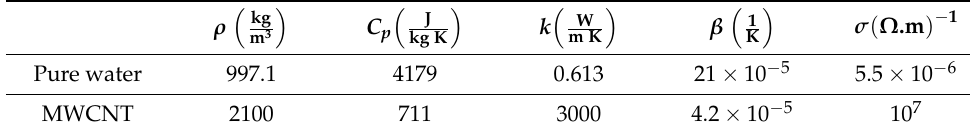
Figure 1. Graphical visualization of domain. Table 1. Thermophysical characteristics of water and nanoparticles.